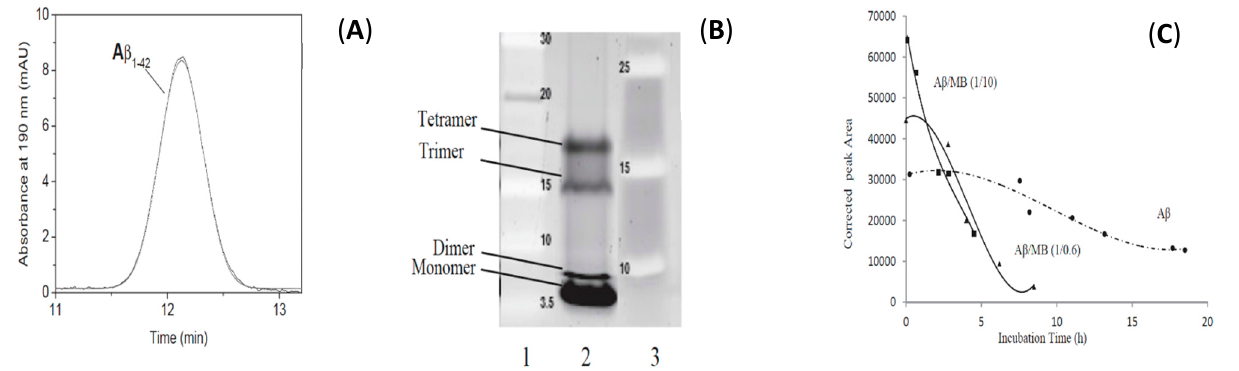
Figure 8. Electrophoretic study of A β 1–42 sample. ( A ) TDA (UV Trace) ( B ) Tris-glycine-17%-SDS-Page analysis. ( C ) Corrected absolute peak areas over time of the electrophoretic profiles of A β 1–42 in presence (two ratios) or absence of Methylene Blue. Adapted with permission from Reference [125].